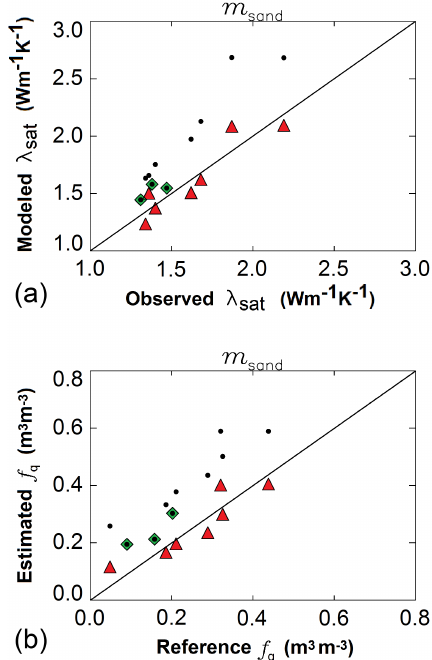
Figure 9. Estimated λ sat and volumetric fraction of quartz f q (top and bottom, respectively) vs. values derived from the λ sat observa- tions of Lu et al. (2007) given by Tarnawski et al. (2009) for 10 Chi- nese soils, using the gravimetric fraction of sand m sand as a predic- tor of f q . Dark dots correspond to the estimations obtained using the m sand pedotransfer function for southern France, and the three soils for which m sand /m SOM < 40 are indicated by green diamonds. Red triangles correspond to the estimations obtained using the m sand pe- dotransfer function for the seven soils for which m sand /m SOM > 40 (see Table